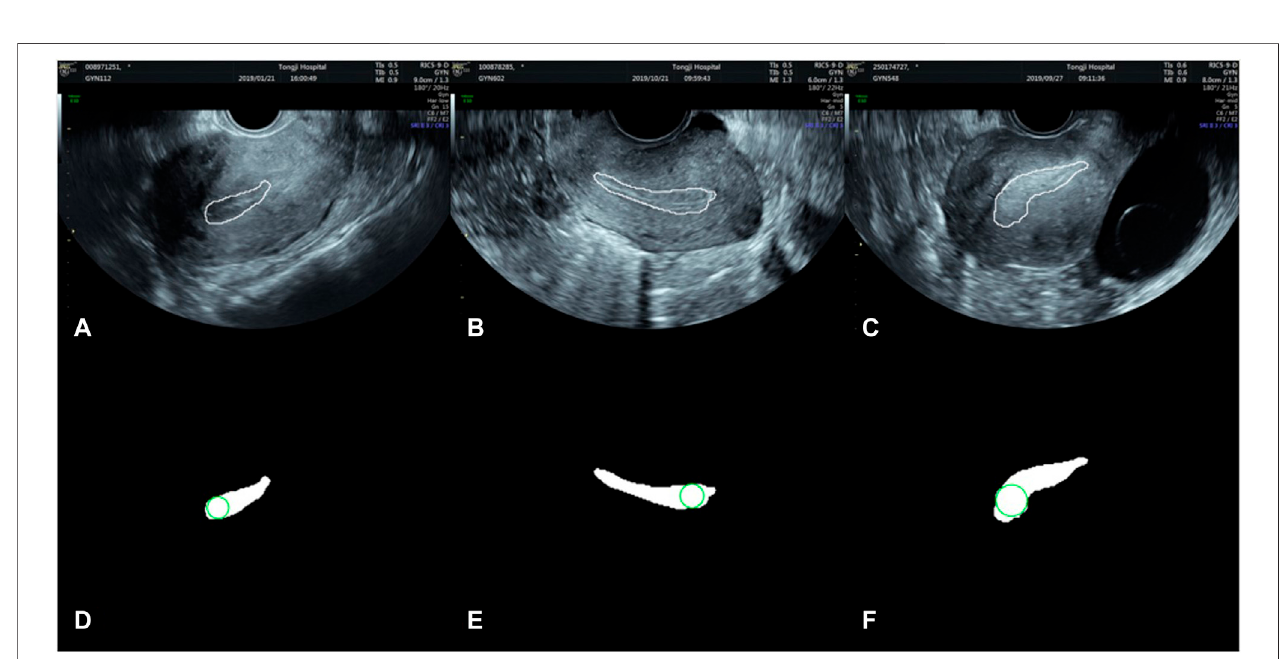
FIGURE 5 | Automatically search the largest inscribed circle on the segmented endometrial mask. (A – C) are the segmentation results in the original images, and (D – F) the largest inscribed circles on the segmented endometrial masks.